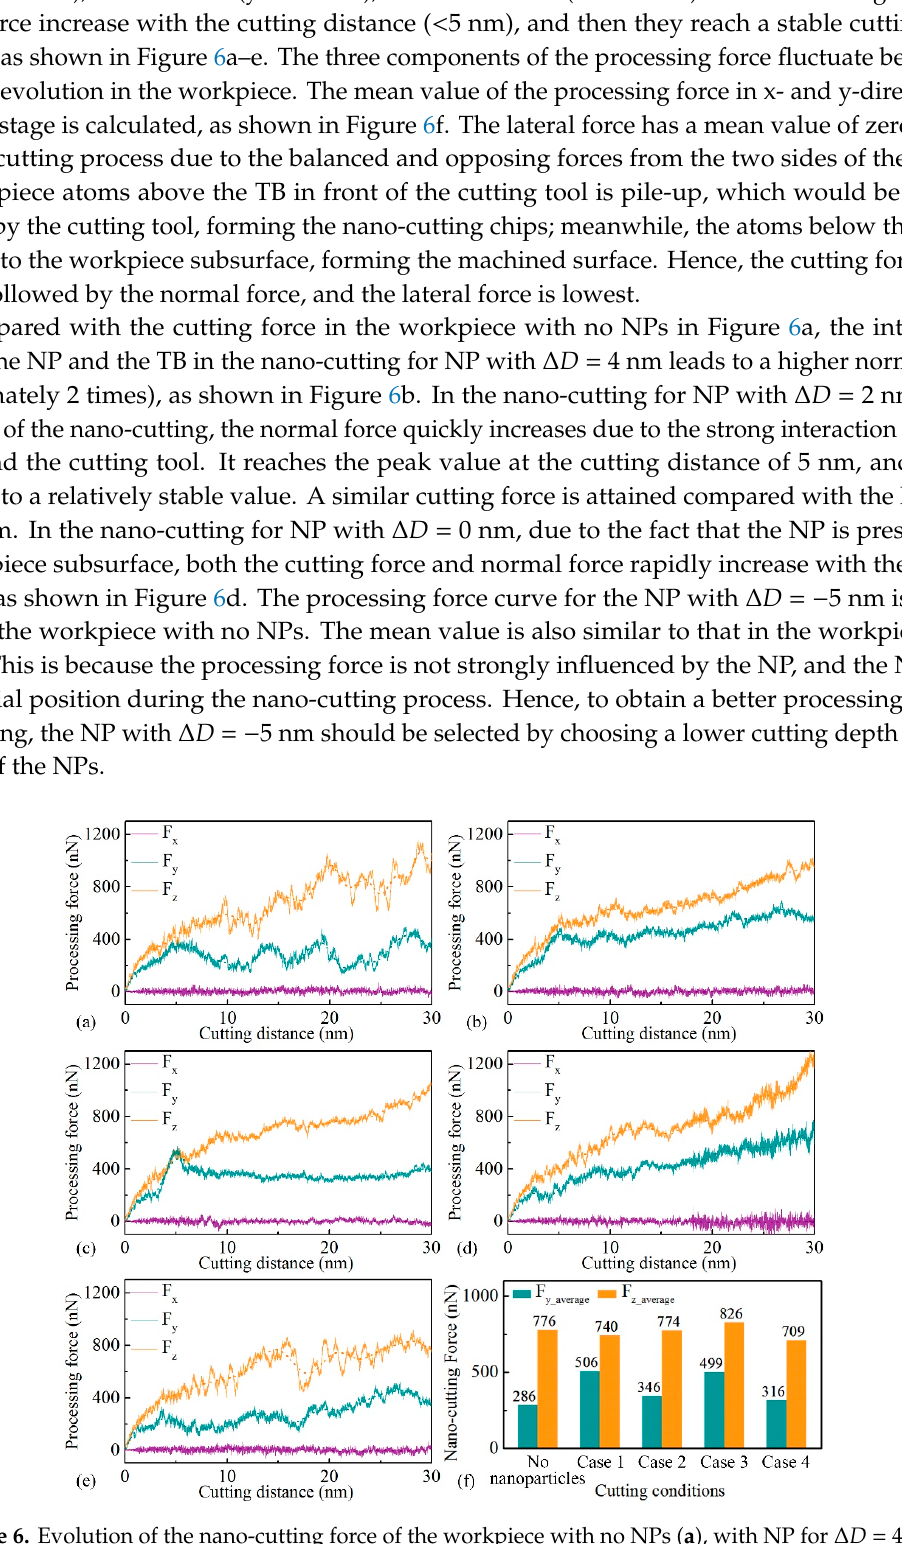
Figure 5. Machined surface quality of the workpiece with no NPs ( a ), with NP for Δ D = 4 nm ( b ), 2 nm ( c ), 0 nm ( d ), and − 5 nm ( e ) under the workpiece free surface .